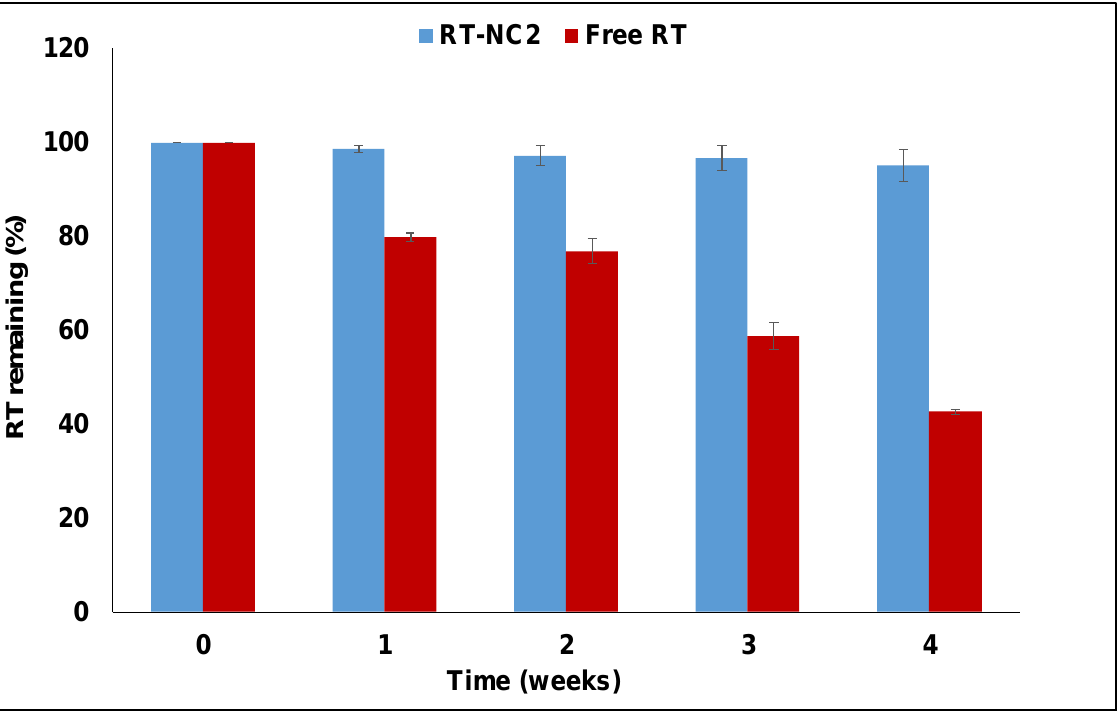
Figure 1. Percent remaining of RT as a function of exposure time to light for free RT and RT nanocrystals formulation RT-NC2. Table 4. Effect of storage at room temperature (25 °C) and 4 °C on the percent drug entrapment efficiency (%EE), particle size (nm), and polydispersity index (PDI) of RT nanocrystals formulation RT-NC2.